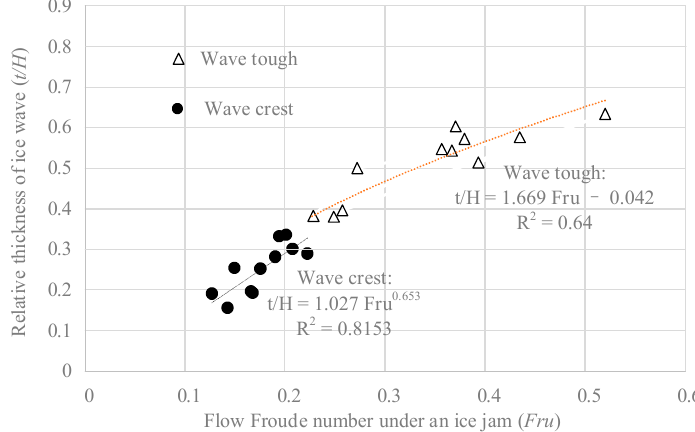
Figure 8. Relationship between the relative thickness of ice wave (at wave crest and wave trough) and flow Froude number under an ice jam based on laboratory experiments.